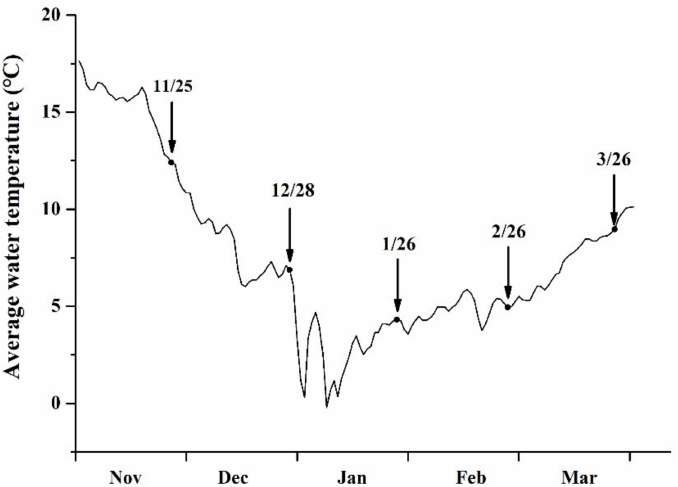
Figure 1. Variation of the sea surface temperature from November 2020 to March 2021 in Jimo sea